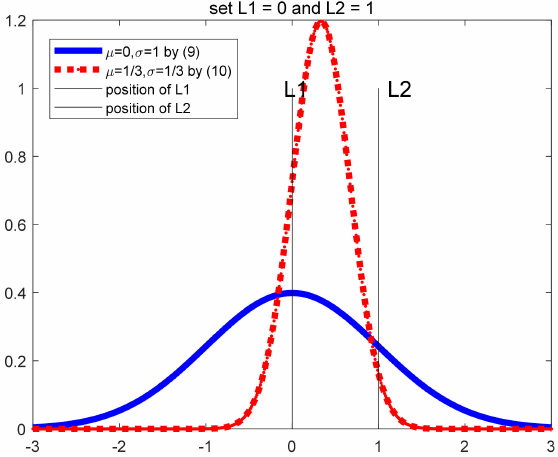
Figure 3. The difference between two specifications of µ and σ